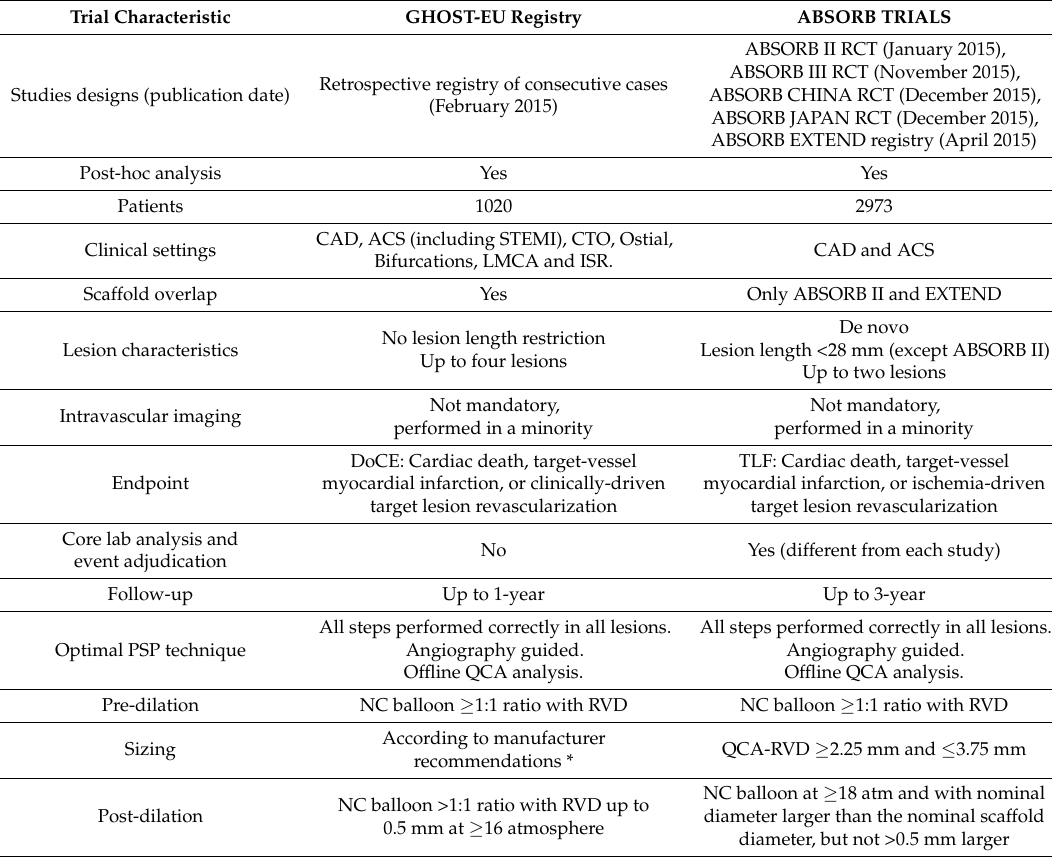
Table 2. Comparison of the study population, methodology, and definition of the optimal PSP technique in the GHOST-EU registry and the ABSORB